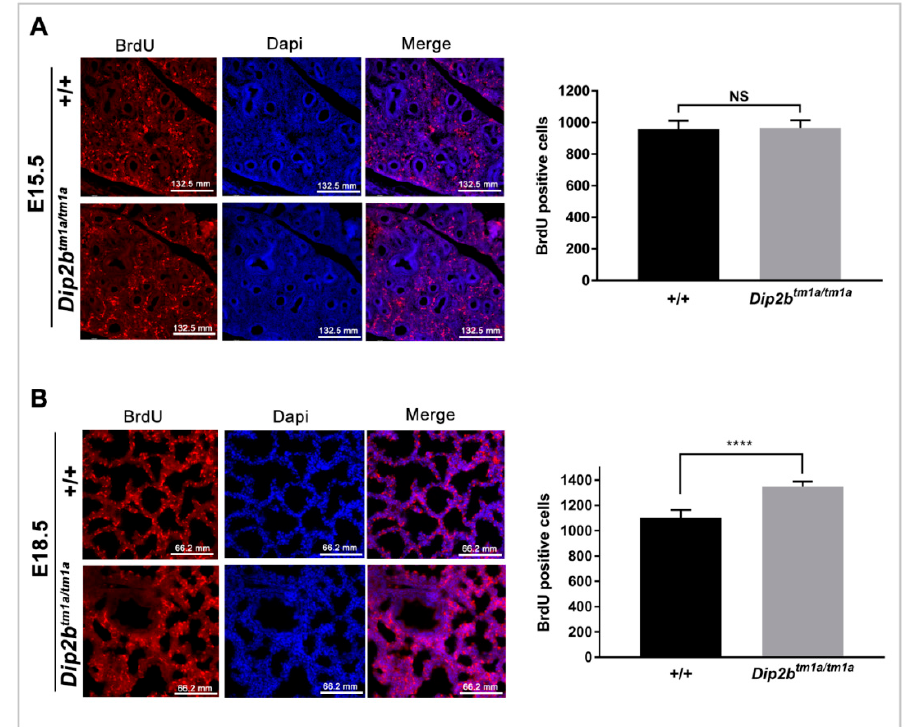
Figure 5. Cell proliferation assay by Bromodeoxyuridine (BrdU) incorporation in lungs: ( A ) BrdU-Positive cell number in E15.5 lungs. Scale bars, 132.5 µ m; ( B ) Cell proliferation assay at E18.5. Scale bars, 66.2 µ m. NS = not significant, **** p < 0.0001 by student’s t -test. Three pubs were analyzed per group.